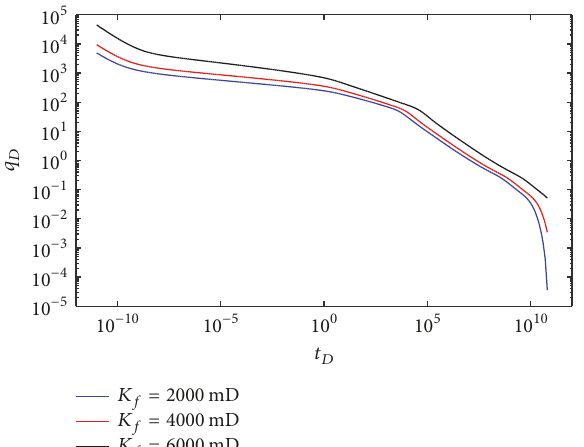
Figure 14: Effect of induced fracture permeability on production.